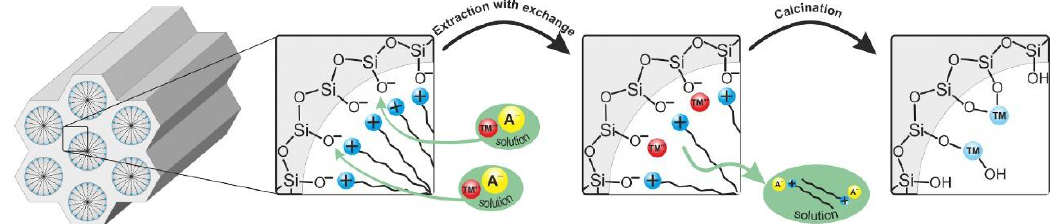
Figure 4. Schematic presentation of the procedure of transition metal deposition on the surface of as-prepared MCM-41 by TIE method: TM n+ , transition metal cations; and A − , anions. Reprinted